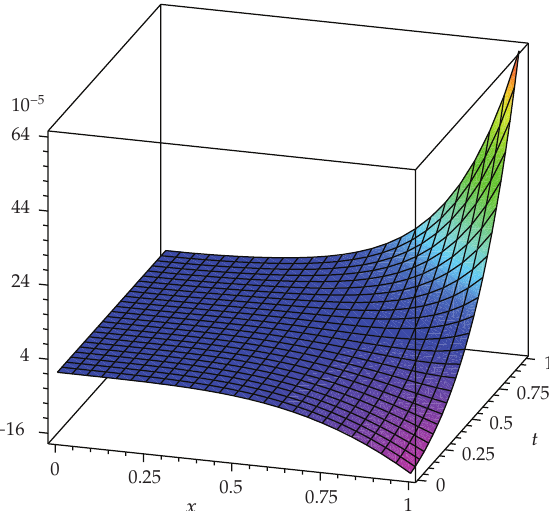
Figure 3: Absolute error of the nonlinear di ff usion problem on the interval (cid:5) 0 , 1 (cid:6) .